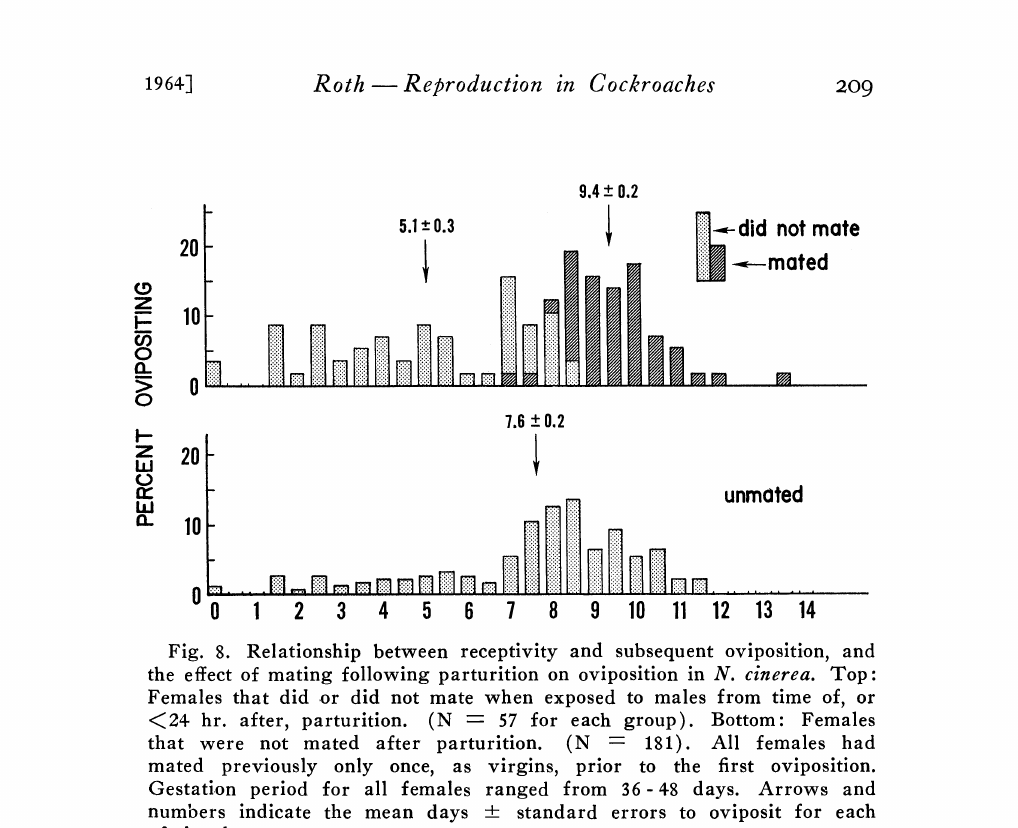
Fig. 8. Relationship between receptivity and subsequent ovipositi.on, and the effect of mating following parturition on oviposition in N. cinerea. Top: Females that did .or did not mate when exposed to males from time of, or 24 hr. after, parturition. (N 57 for each group). Bottom: Females that were not mated after parturition. (N 181). All females had mated previously only once, as virgins, prior to the first oviposition. Gestation period for all females ranged from 36-48 days. Arrows and numbers indicate the mean days 4- standard errors to oviposit for each of the three